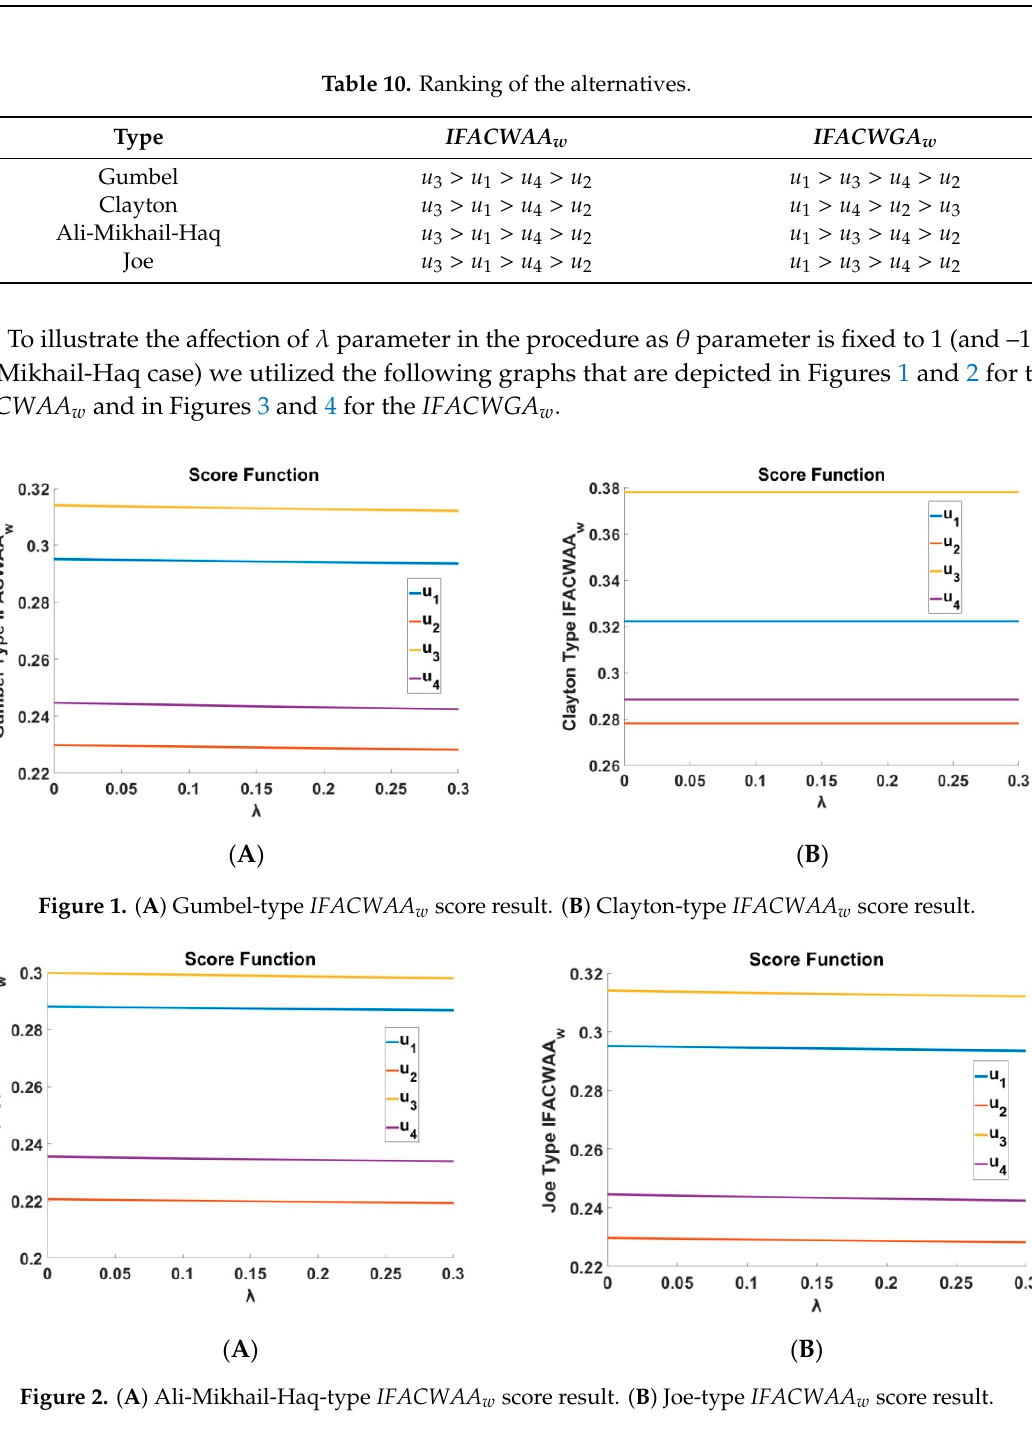
IFACWAA score result. w